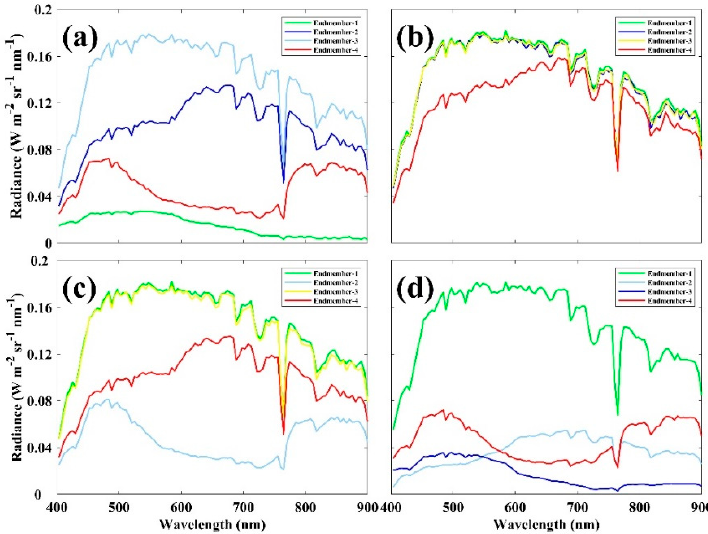
Figure 7. Comparison of endmember spectra radiance using different spectral mixture algorithms ( a ) N-FINDR, ( b ) pixel purity index (PPI), ( c ) independent component analysis (ICA), and ( d ) vertex component analysis (VCA).